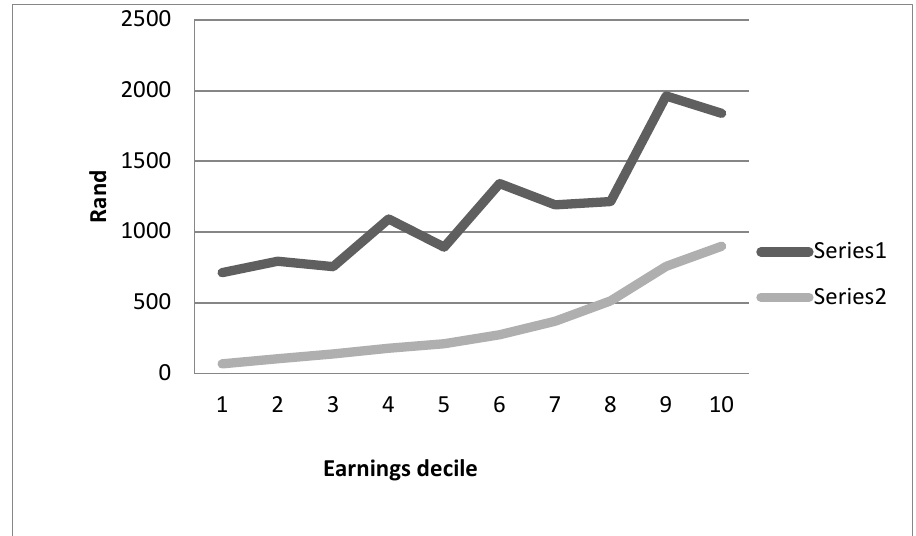
FIGURE 1: Means of Initial Investment (series 1) and Earnings per day (series 2) per earnings decile Source: Author's own analysis